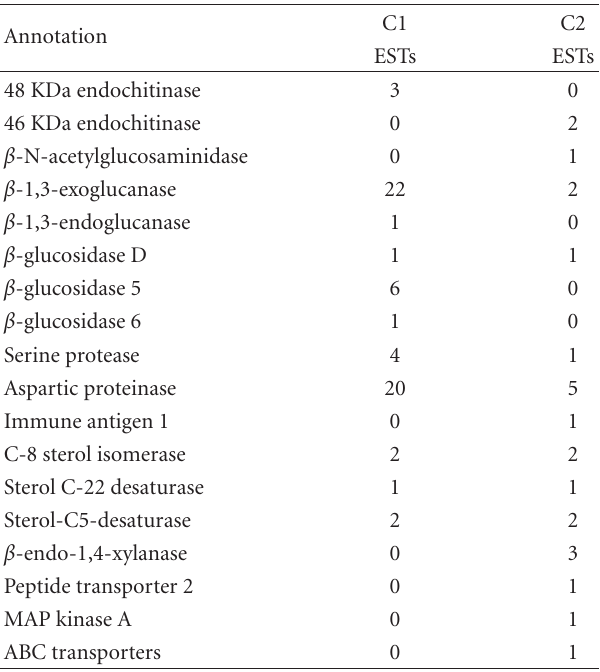
Table 3: The di ff erent expression of genes related to biocontrol be- tween cDNA libraries from C. cupreum